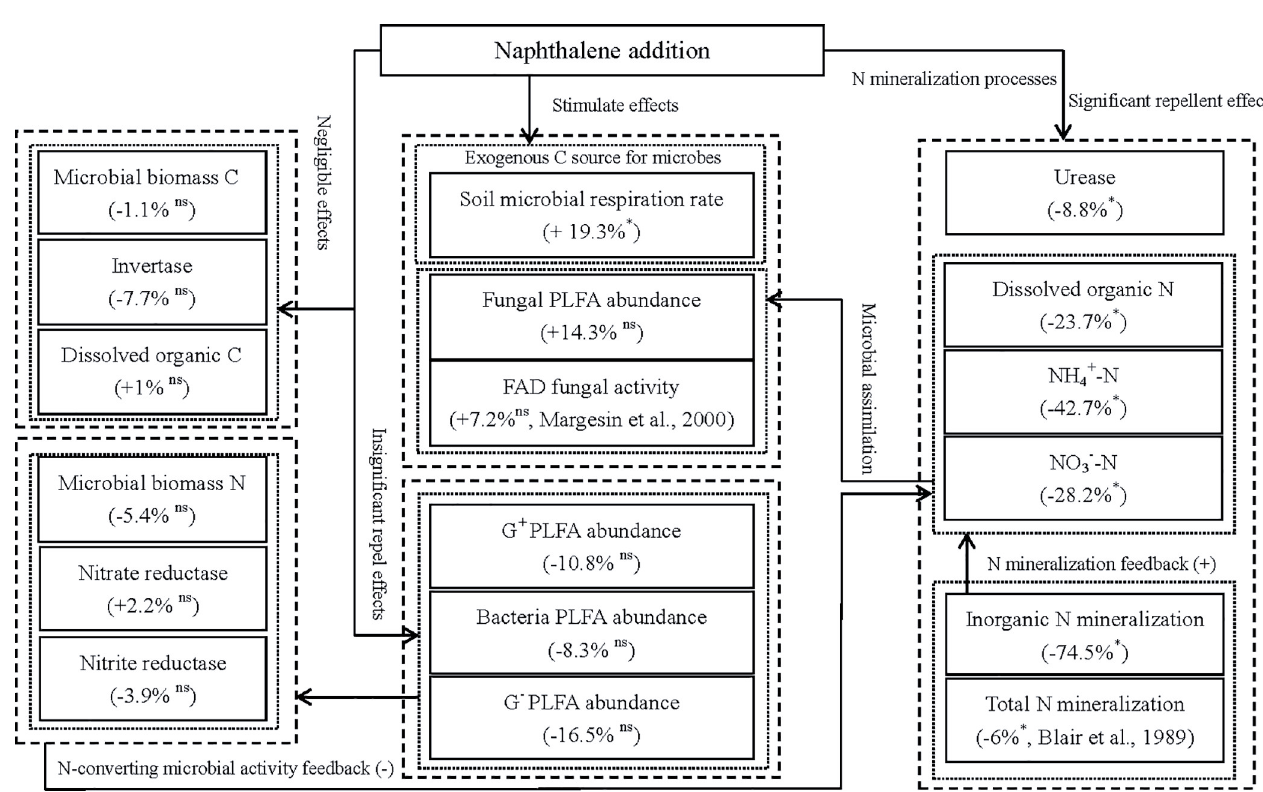
Fig 6. A quantitative framework for the nontarget effects of naphthalene addition on soil biochemical properties. +, positive;–, negative; � , P < 0.05; ns, nonsignificant; # data for FAD fungal activity and total N mineralization are from Margesin et al. (2000) and Blair et al. (1989), respectively.